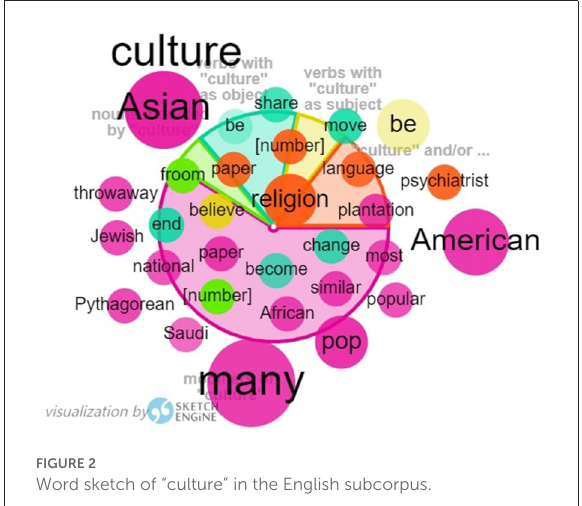
FIGURE2 Word sketch of “culture” in the English subcorpus.